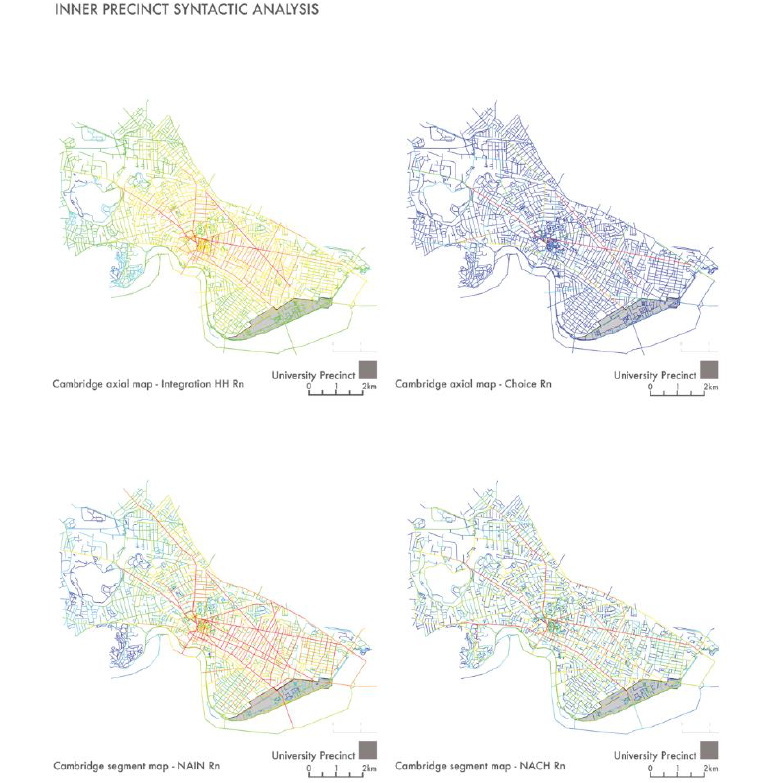
Figure 4 Cambridge, Massachusetts axial and segment maps and MIT Campus